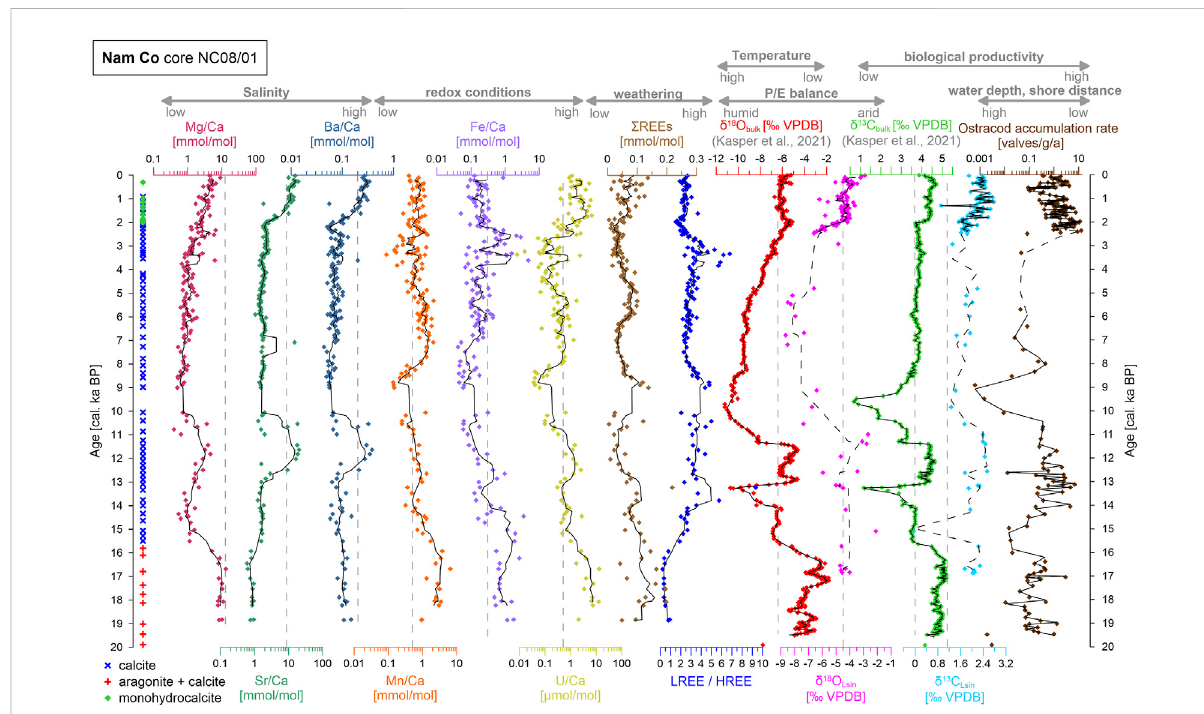
FIGURE 2 Nam Co trace element, REE and stable isotope records of ostracod shells ( δ 18 O Lsin and δ 13 C Lsin , Lsin = Leucocytherella sinensis ) as well as bulk isotopes ( δ 18 O bulk , δ 13 C bulk ; Kasper et al., 2021) from core NC08/01. Authigenic carbonate mineralogy is shown on the left to indicate phases of formation of aragonite (red cross), calcite (blue x), and monohydrocalcite (green diamond). Ostracod Mg/Ca, Sr/Ca, and Ba/Ca ratios represent lake water salinity, ratios of Mn/Ca, Fe/Ca, and U/Ca re fl ect redox conditions and microbial activity. Rare earth elements (REEs) display weathering intensityandprovenancechange,where Σ REEsisthesumoflightREE/Caratios(LREE:La,Ce,Pr,Nd,Sm,Eu)andheavyREE/Caratios(HREE:Gd,Tb, Dy, Ho, Er, Tm, Yb, Lu). Stable oxygen isotopes indicate changes in the precipitation to evaporation ratio (P/E) and meltwater input. Stable carbon isotopes and ostracod accumulation rate re fl ect biological productivity. Very low ostracod accumulation rates are indicative of oxygen de fi ciency, low carbonate contents or calcite dissolution. Dashed lines show levels of modern values from Börner et al. (2017). Solid black lines show 5-point smoothed